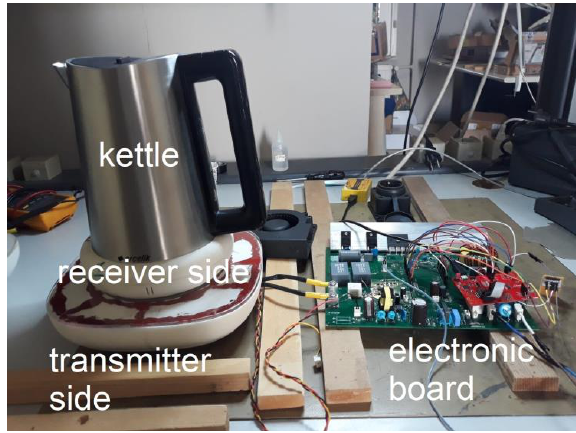
Figure 36. Test setup of kettle for efficiency measurement.